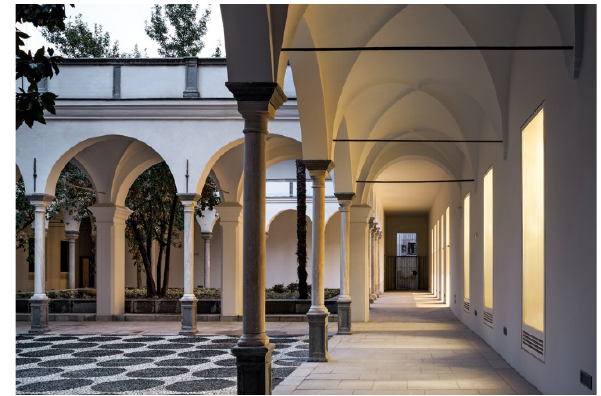
Figure 3. Picture of the Patio at the ground